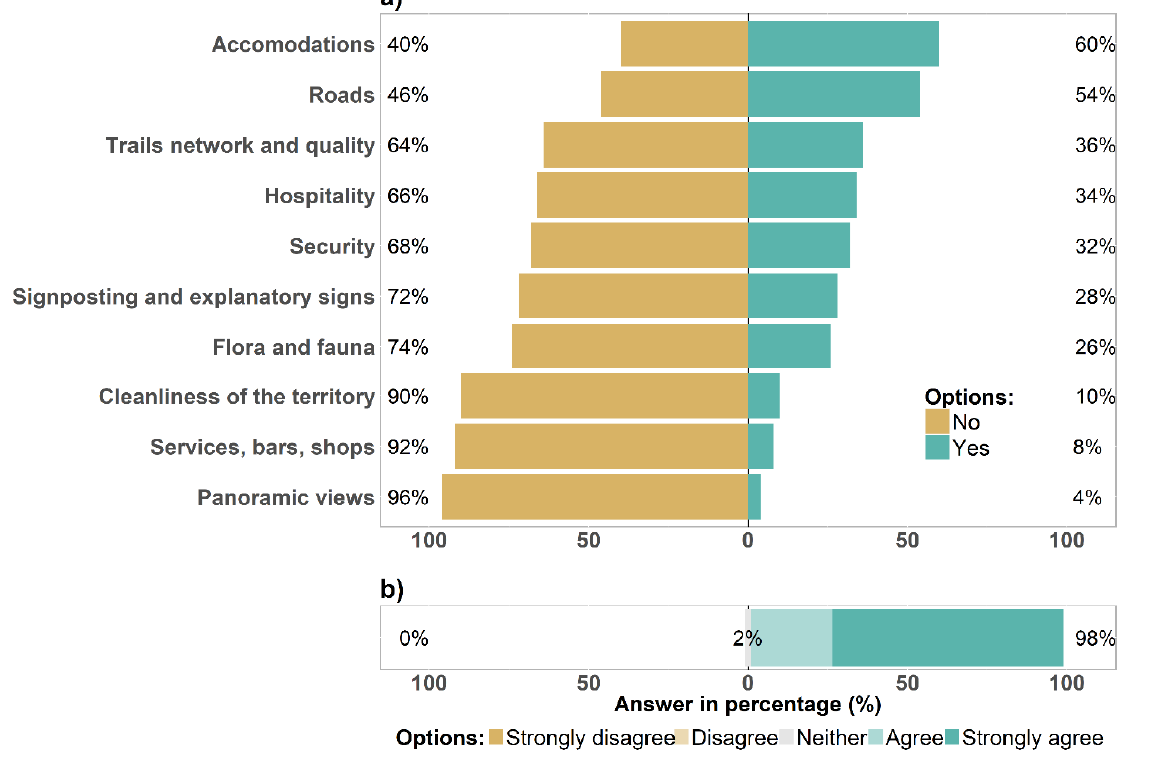
Figure 5. Comparison of engineered facilities favouring tourism using photo surveys: assessment of respondents’